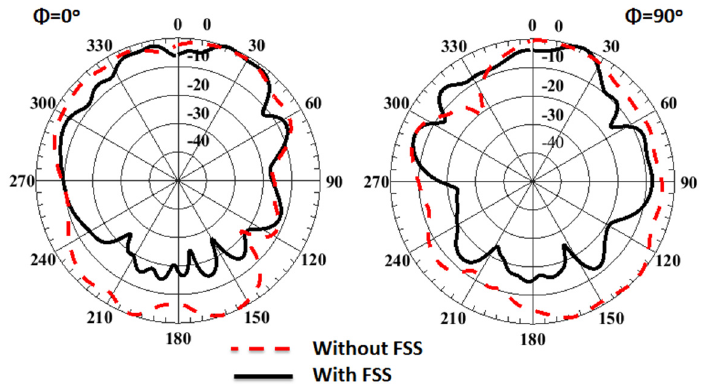
Figure 23. The normalized radiation patterns outcomes of 4-port MIMO antenna at port 1 at 38 GHz with/without FSS. with/without